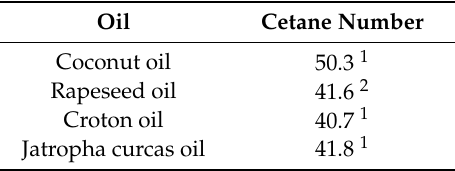
Table 1. Cetane number of vegetable